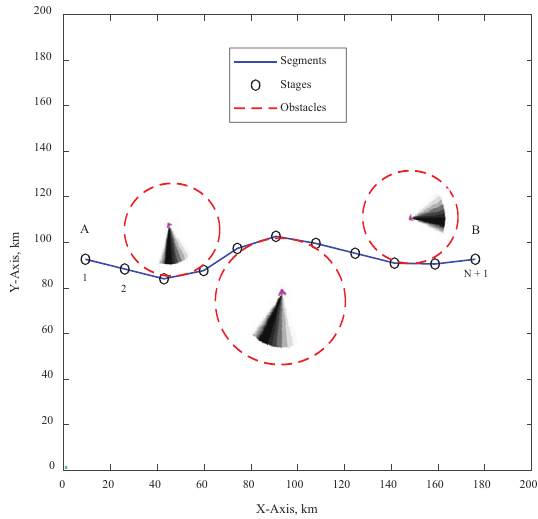
Figure 3. Geometric model for a sample obstacle-avoidance simulation environment without regard for flight mechanics